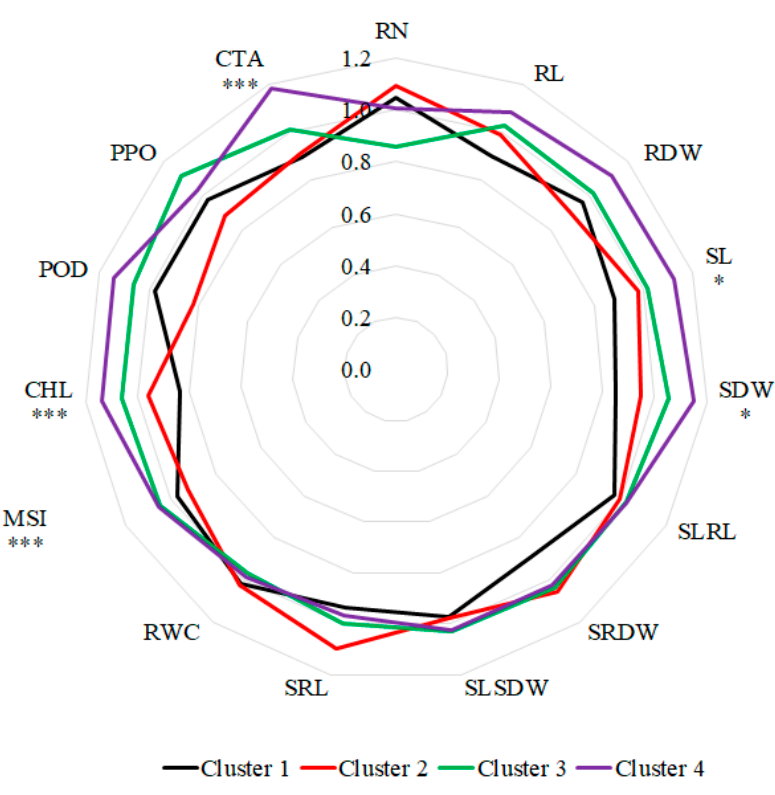
Figure 4. Radar charts comparing 15 traits of the four genetic clusters. Data were analyzed using one-way ANOVA. * and *** indicate significance at p < 0.05 and 0.001, respectively. roots number (RN), root length (RL), root dry weight (RDW), shoot length (SL), shoot dry weight (SDW), shoot root length ratio (SLRL), shoot root dry weight ratio (SRDW), shoot length shoot dry weight ratio (SLSDW), specific root length (SRL), relative water content (RWC), membrane stability index (MSI), chlorophyll content (CHL), peroxidase (PPD), polyphenol oxidase (PPO), and catalase (CAT).